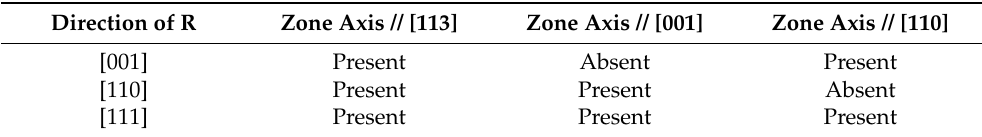
Table 2. Appearance or disappearance of diffuse satellites for combinations of examined zone axis and [001], [110], and [111] displacement direction R . Direction of R